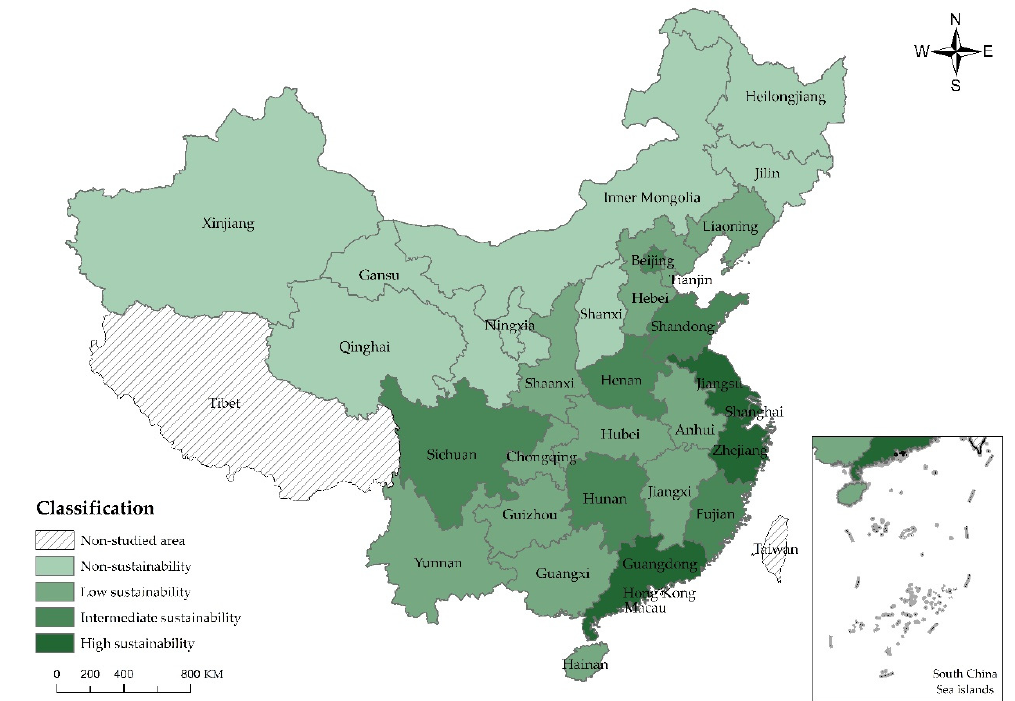
Figure 4. Comparison chart of sustainable capacity of auxiliary industry in China.